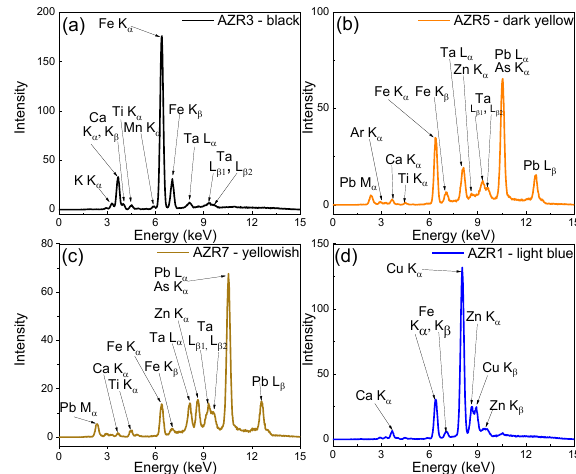
Fig. 2. XRF spectra, collected in the 0-14 keV range, on (a) the black glazed surface of sample AZR3, (b) the dark yellow glazed surface of sample AZR5, (c) the yellowish glazed surface of sample AZR7, and (d) the light blue glazed surface of sample AZR1.